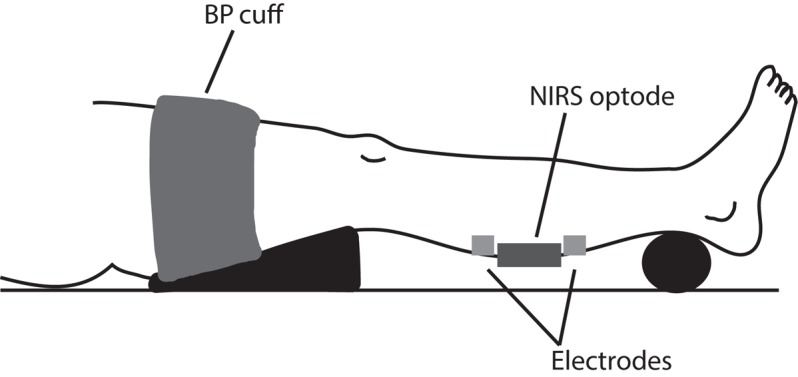
Experimental setup.